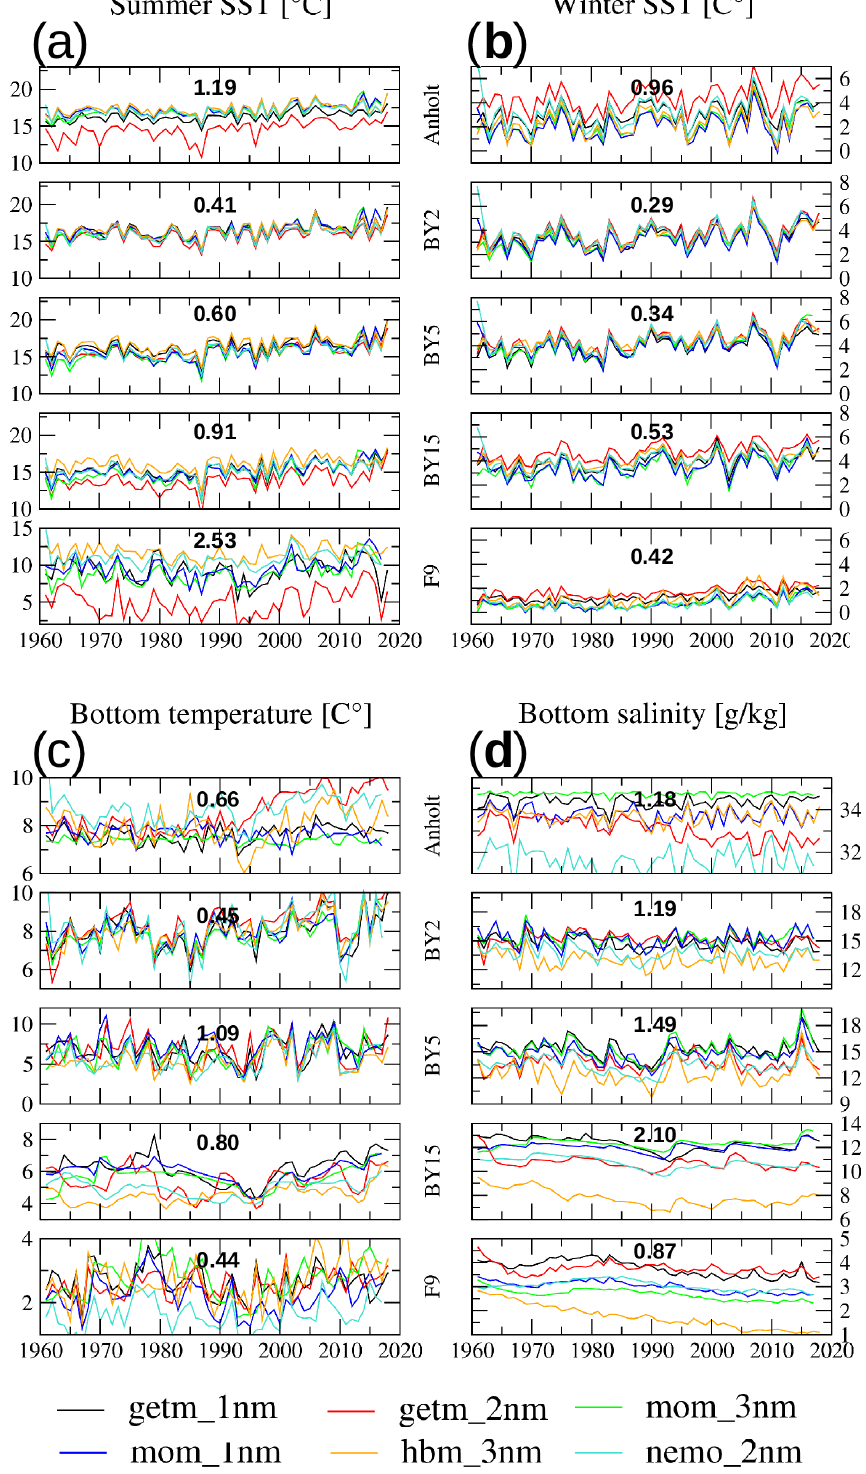
Figure 7. Intermodel comparison of a long-term time series of (a) the mean summer (JJA) and (b) winter (DJF) SST in addition to the annual mean (c) bottom temperature and (d) salinity at selected sites in the Baltic Sea. Numbers in the respective panels denote intermodel standard deviations averaged over the entire period